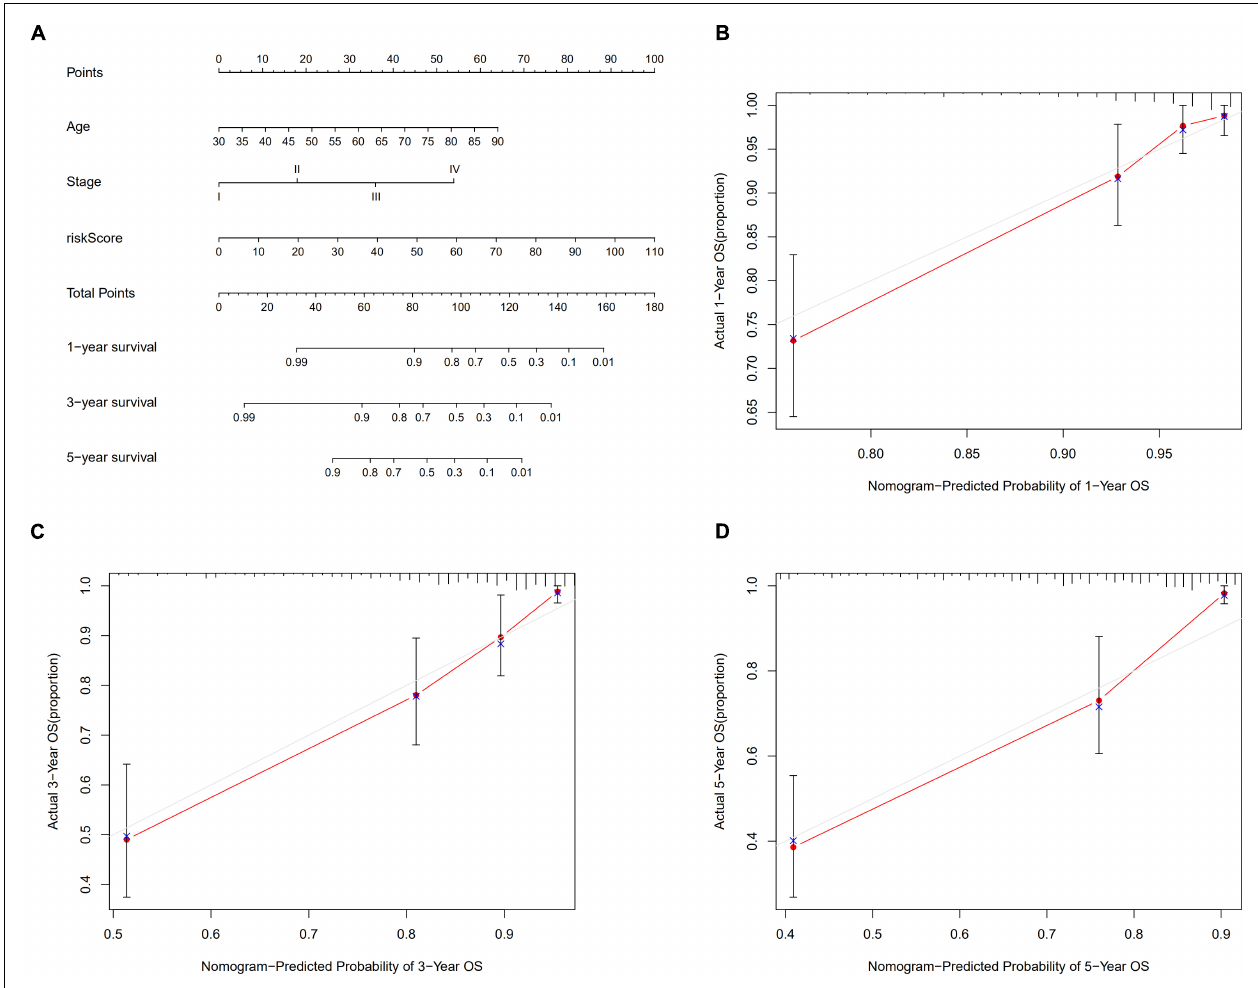
FIGURE 7 | Nomogram model (A) to predict 1-, 3-, and 5-year survival rates of colon cancer cases. Calibration graphs indicated that predicted 1- (B) , 3- (C) and 5- (D) year survival rates were close to the actual survival